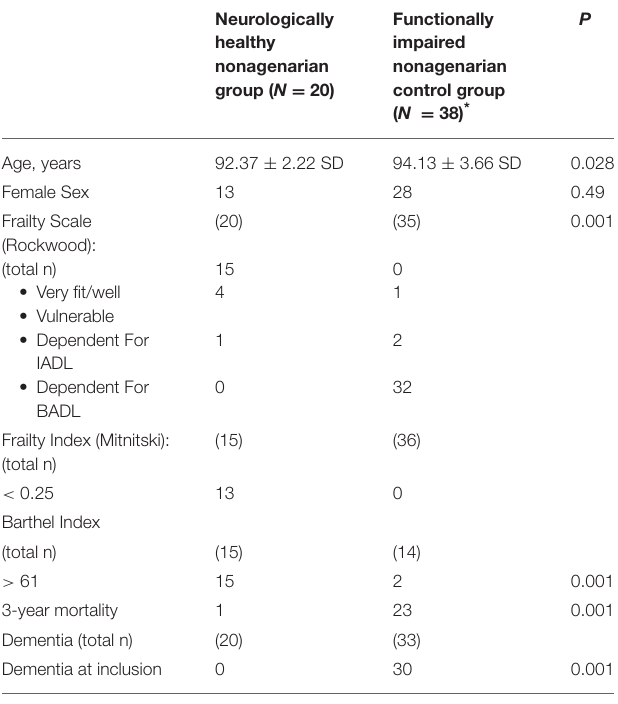
TABLE 1 | Demographic, cognitive, frailty and mortality characteristics of our cohort. Neurologically